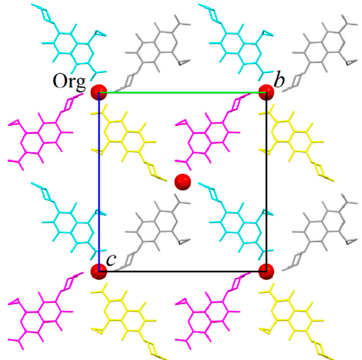
Figure 5. Partial packing of ORBI hemihydrate form showing a layer formed normal to the unit cell a axis. The layer was generated from the asymmetric unit applying the symmetry operations included in Figure 4 captions. The colour scheme refers to four of the eight equivalents by symmetry positions of the C222 1 space group. Water oxygen atoms are represented as red spheres. Hydrogens were omitted for